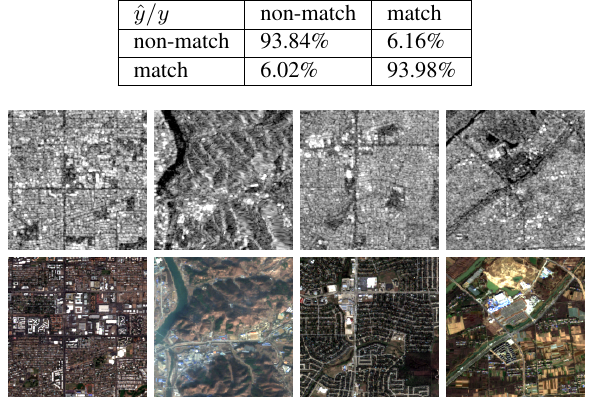
Table 1. Confusion Matrix for Pseudo-siamese patch matching